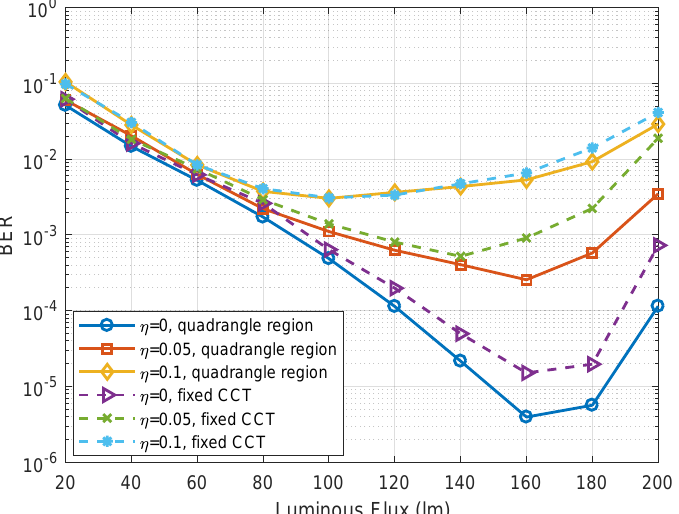
Figure 6. The BER performance of the proposed precoder and chromaticity-fixed precoder versus luminous flux with different interference ratios η when CCT = 5000